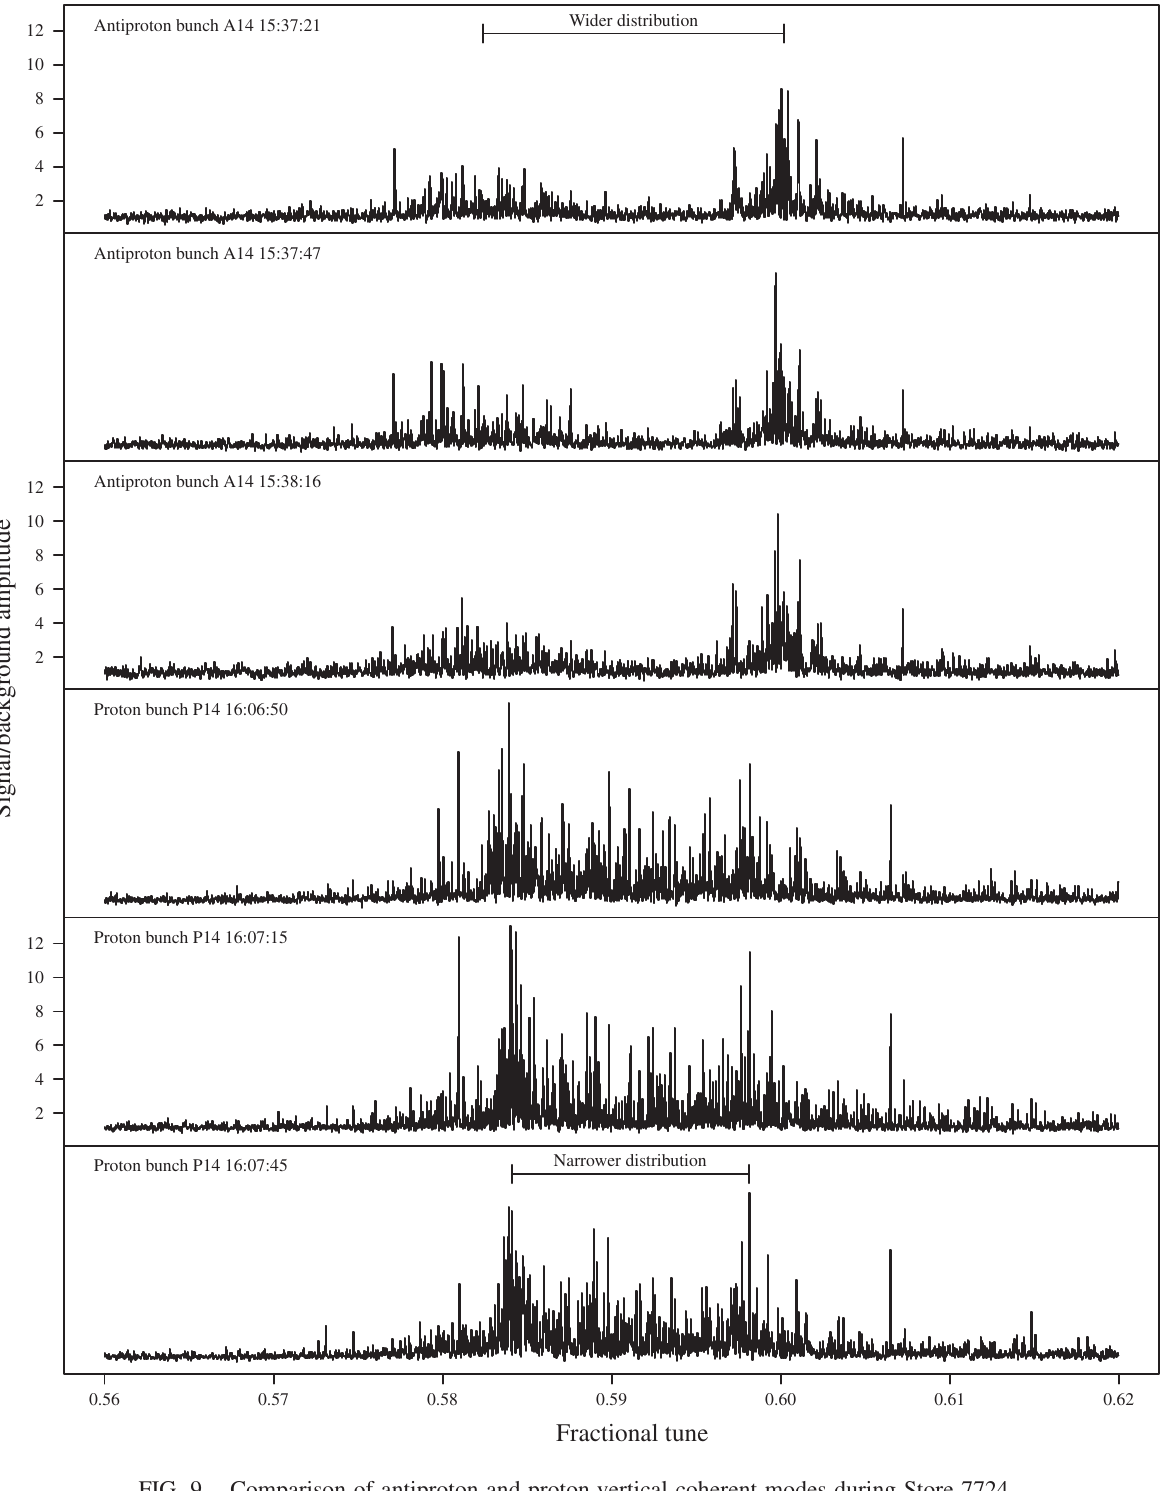
FIG. 9. Comparison of antiproton and proton vertical coherent modes during Store